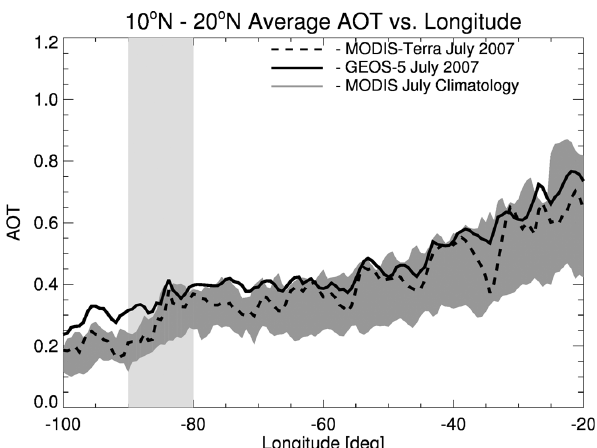
Fig. 2. MODIS-Terra/Aqua July climatological (2002–2010) AOT (shading), MODIS-Terra July 2007 AOT (dashed) and GEOS-5 sampled (solid) July 2007 AOT averaged from 10 ◦ –20 ◦